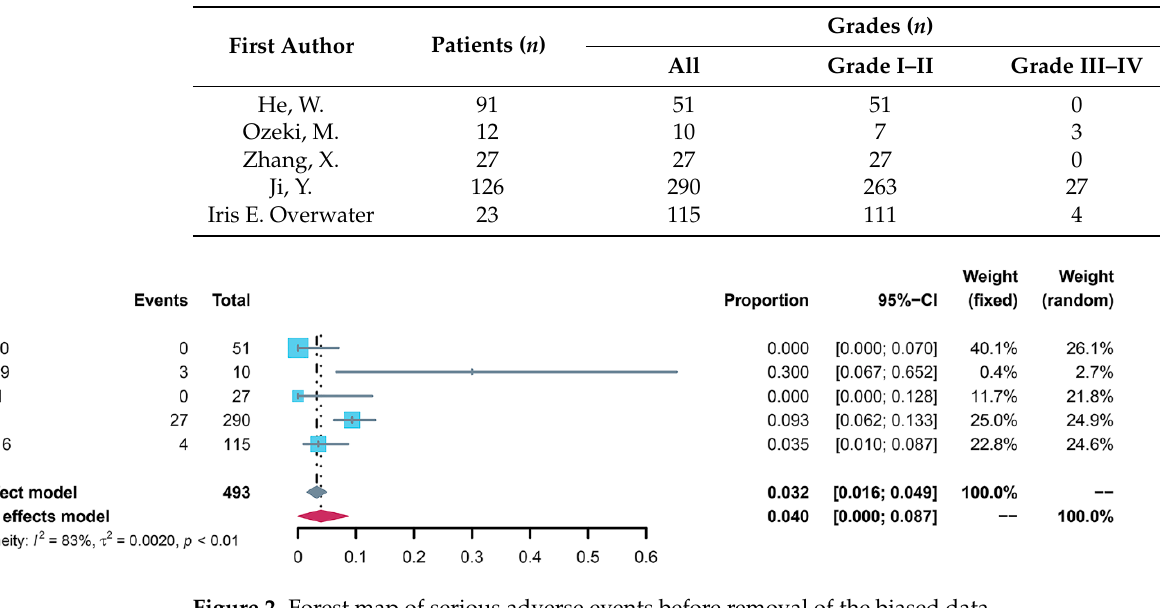
Figure 2. Forest map of serious adverse events before removal of the biased data.